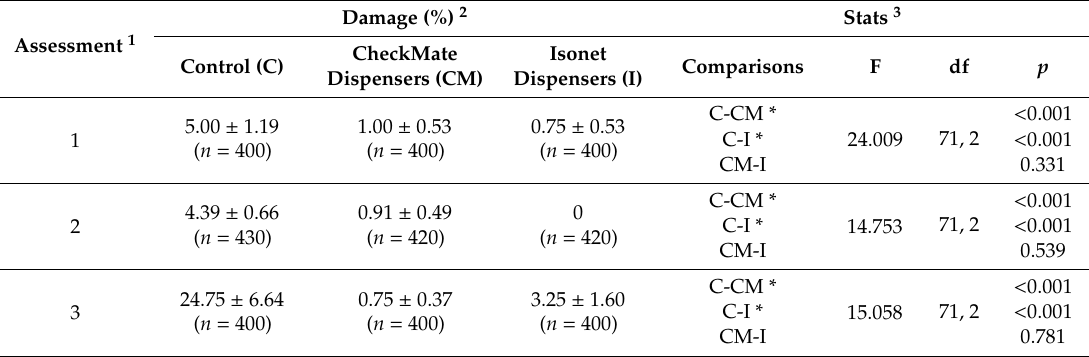
Table 4. Mean (± SE) percentage of damaged bunches obtained in each treatment in the three damage assessments carried out at Location 1 and 2.